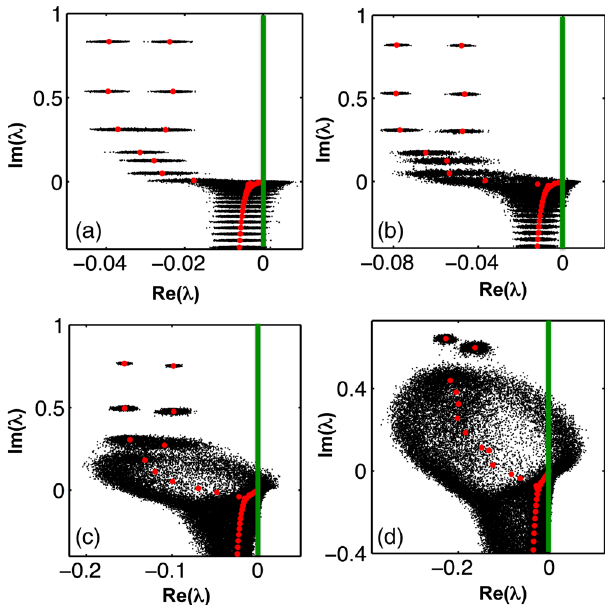
FIG. 9. Four ϵ ¼ 0 . 1 pseudospectra of the non-normal potential shown in Fig. 1, where the gain and loss amplitudes g are equal to (a) 0.5, (b) 1, (c) 2, and (d) 3. All plots are shown in the complex plane, and the red dots depict the eigenvalue spectrum and the green line the imaginary axis.